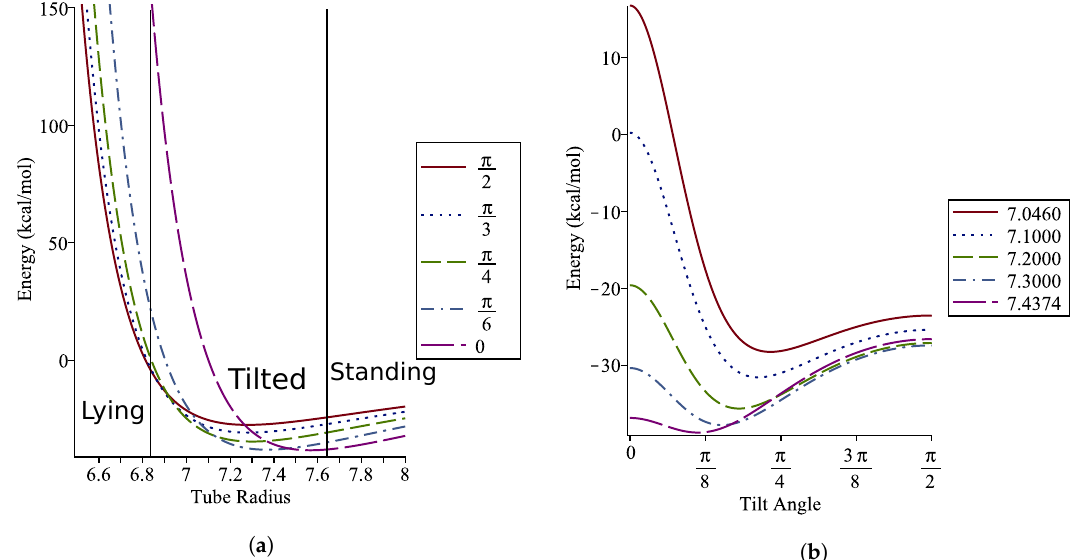
Figure 9. Energy profiles with ( a ) fixed angles showing the minimum energy regimes and ( b ) fixed radii showing variation in optimal angles in tilted